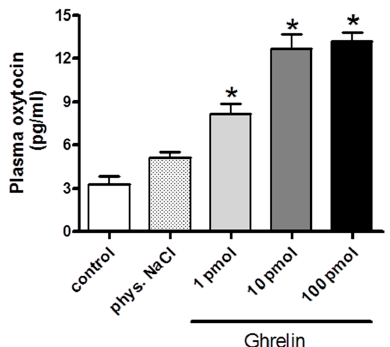
Figure 1. Dose–response effects of centrally (i.c.v.) administrated ghrelin on plasma oxytocin release (expressed as pg/ml). Results shown as means ± S.E.M., n = 10. Statistical significance: * p < 0.05 relative to the control group .